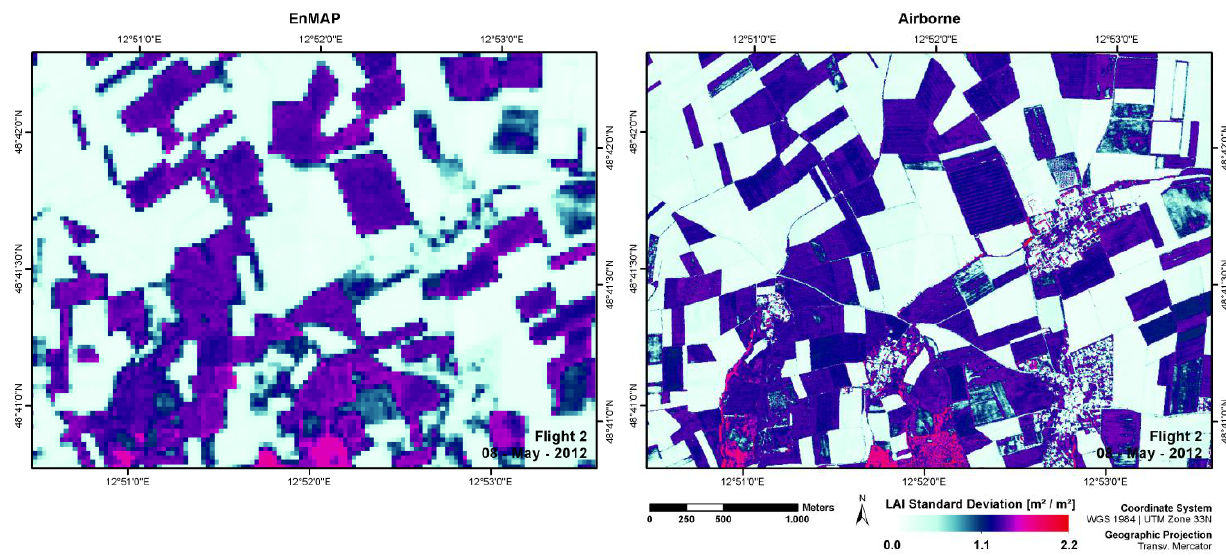
Figure 8. Standard deviation of all considered estimated LAI values ( n = 350) before averaging, giving a spatial measure of model uncertainty for the retrieval of LAI from simulated EnMAP data ( Left ) and from airborne data ( Right